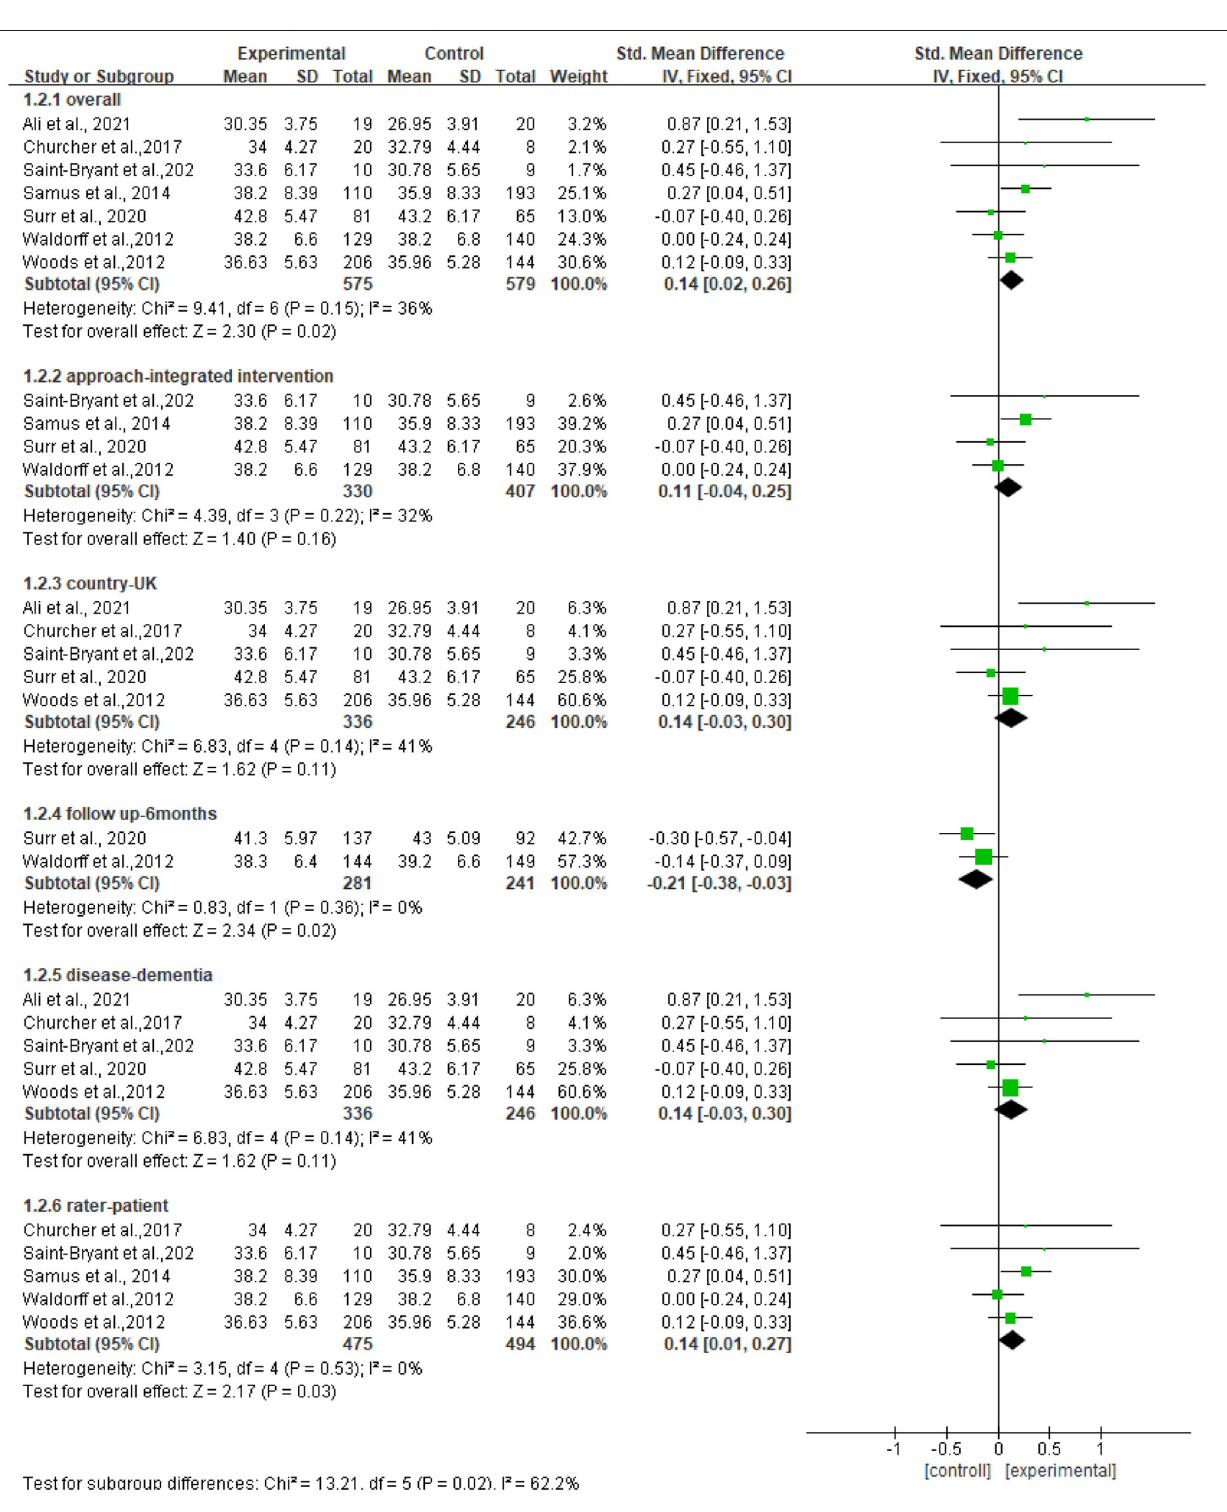
Frontiers in Psychiatry |